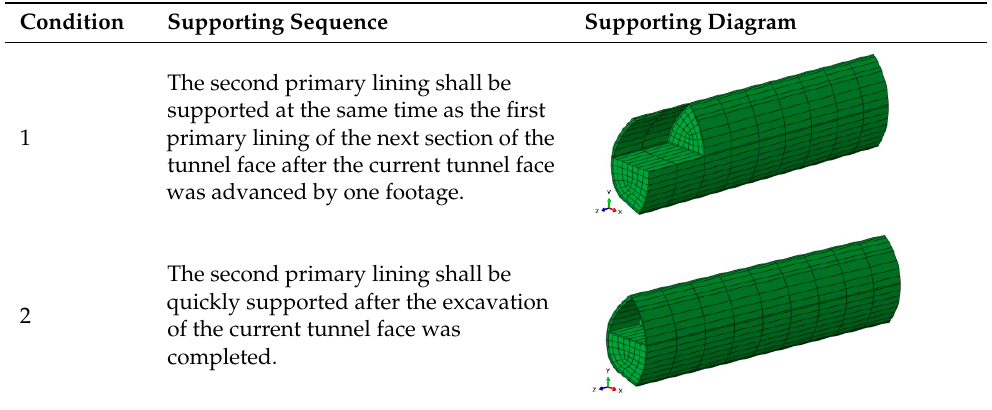
Table 5. The second primary lining support timing.